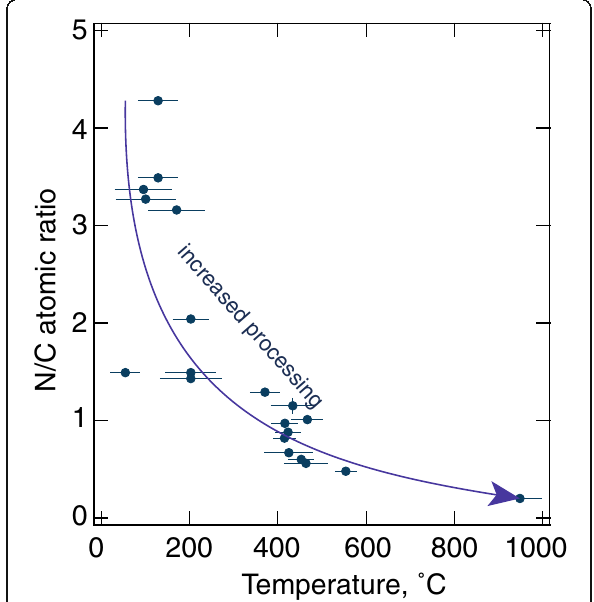
Fig. 13 Relationship between N/C atomic ratios of carbonaceous chondrites and the maximum temperature experienced (temperature of processing) (data from Alexander et al. 2007; Cody et al. 2008)